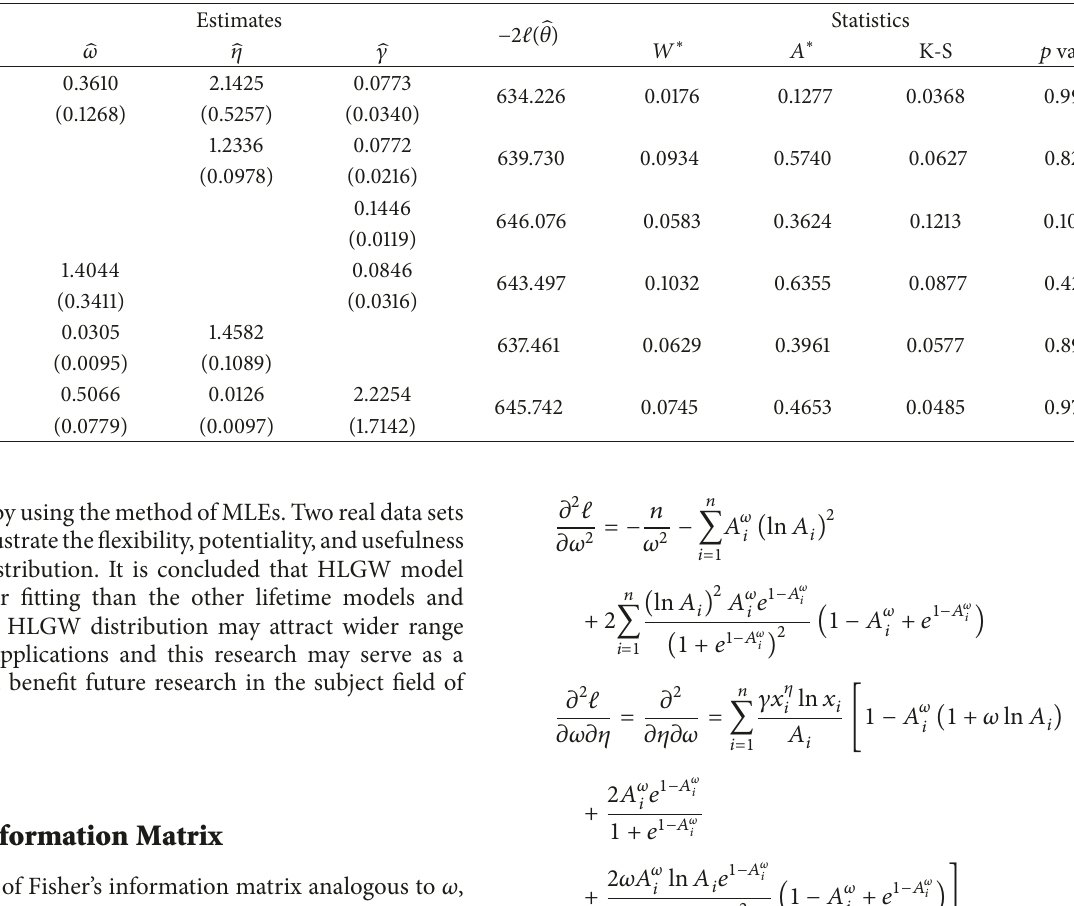
Table 4: Estimates of models for the waiting time